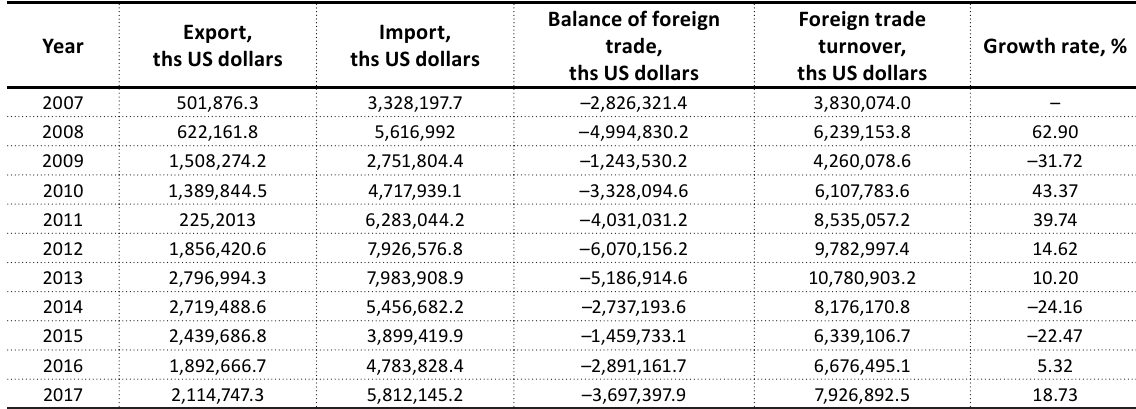
Source: Calculated by the